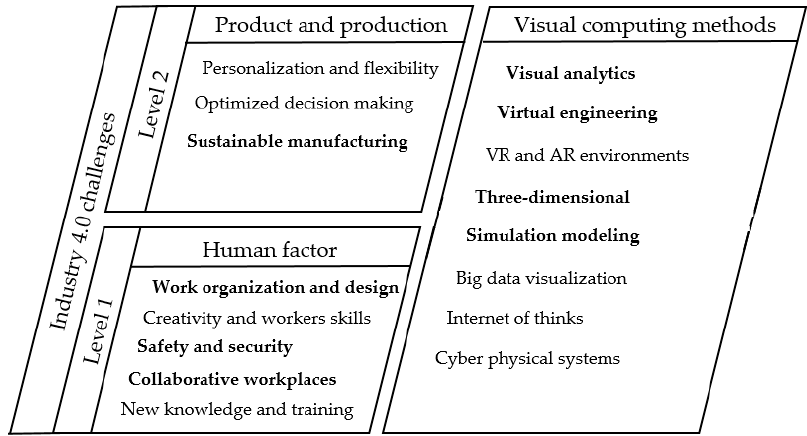
Figure 1. Two-level architecture model highlighting visual computing methods in Industry 4.0 contexts.